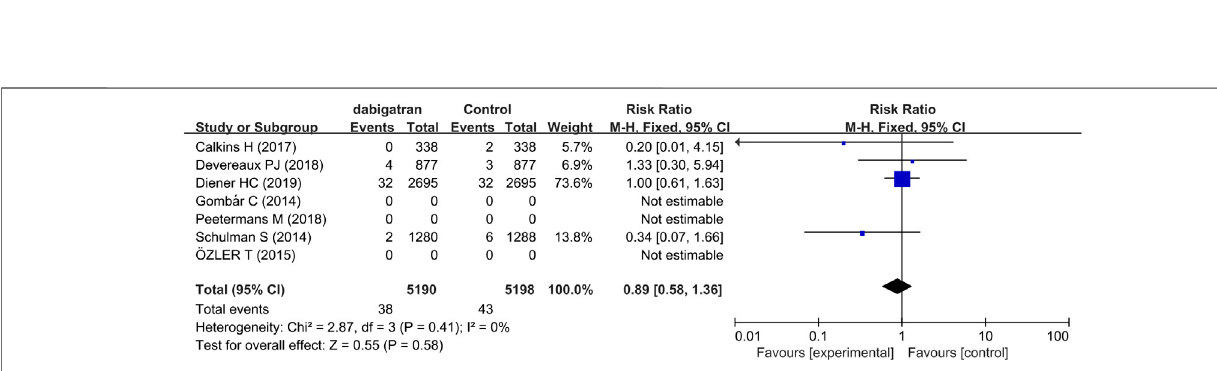
FIGURE 5 | Forest plot comparing the RR of intracranial hemorrhage between the experimental (dabigatran) and control groups.